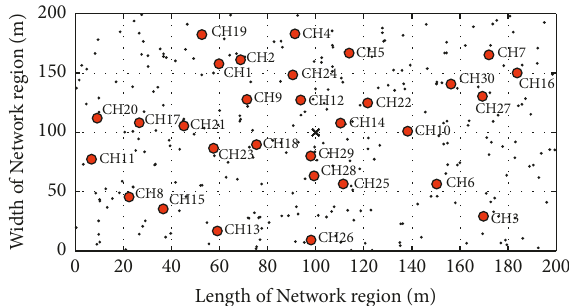
Figure 4: Random deployment of a wireless sensor network with 300 nodes and 30 CHS selected by MRFO algorithm.